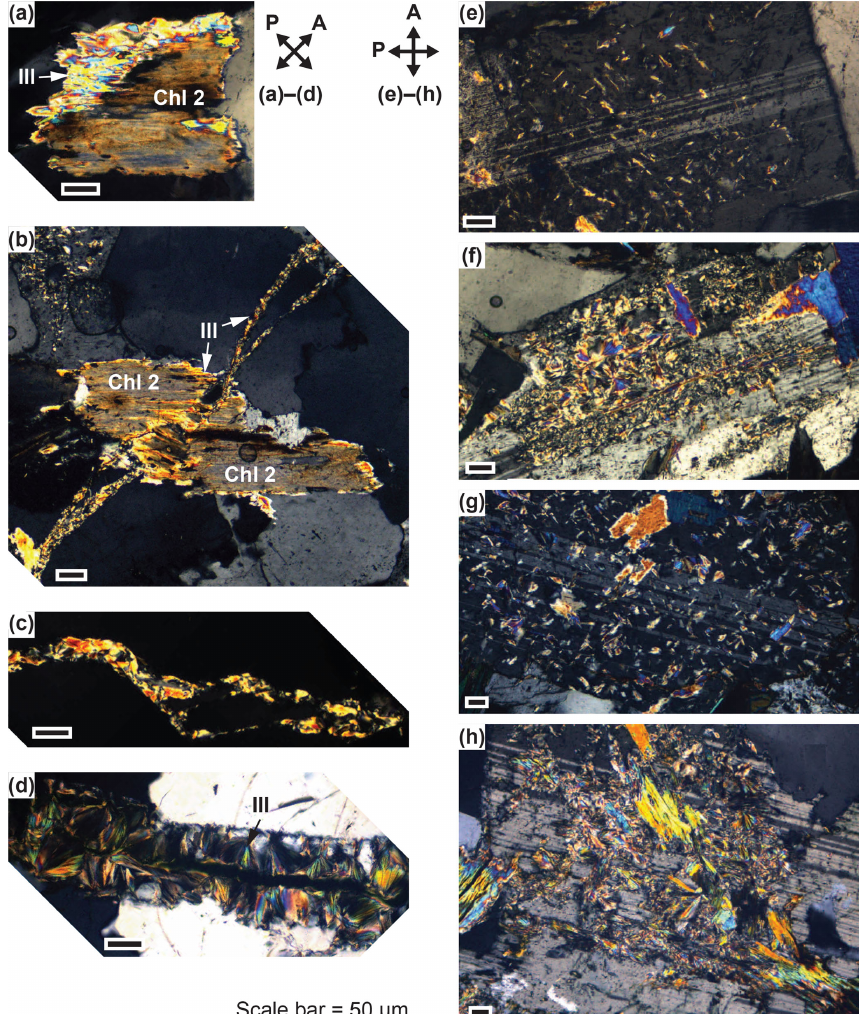
Figure 6. Polarized light photomicrographs showing microstructural position of illite. The double-headed arrows show polarization direction of polarizer (P) and analyzer (A). Partial chlorite (Chl 2) illitization unrelated (a) and related (b) to illite-filled crack (c) in green granite; (d) illite-filled crack in yellow granite; (e) isolated grains of illite in the core of plagioclase in fresh granite; (f) connected fan-shaped aggregates of illite aligned with plagioclase cleavage in green granite; (g) isolated grains of illite homogeneously distributed in plagioclase in brown granite; (h) aggregates of illite in plagioclase in yellow granite. Ill: